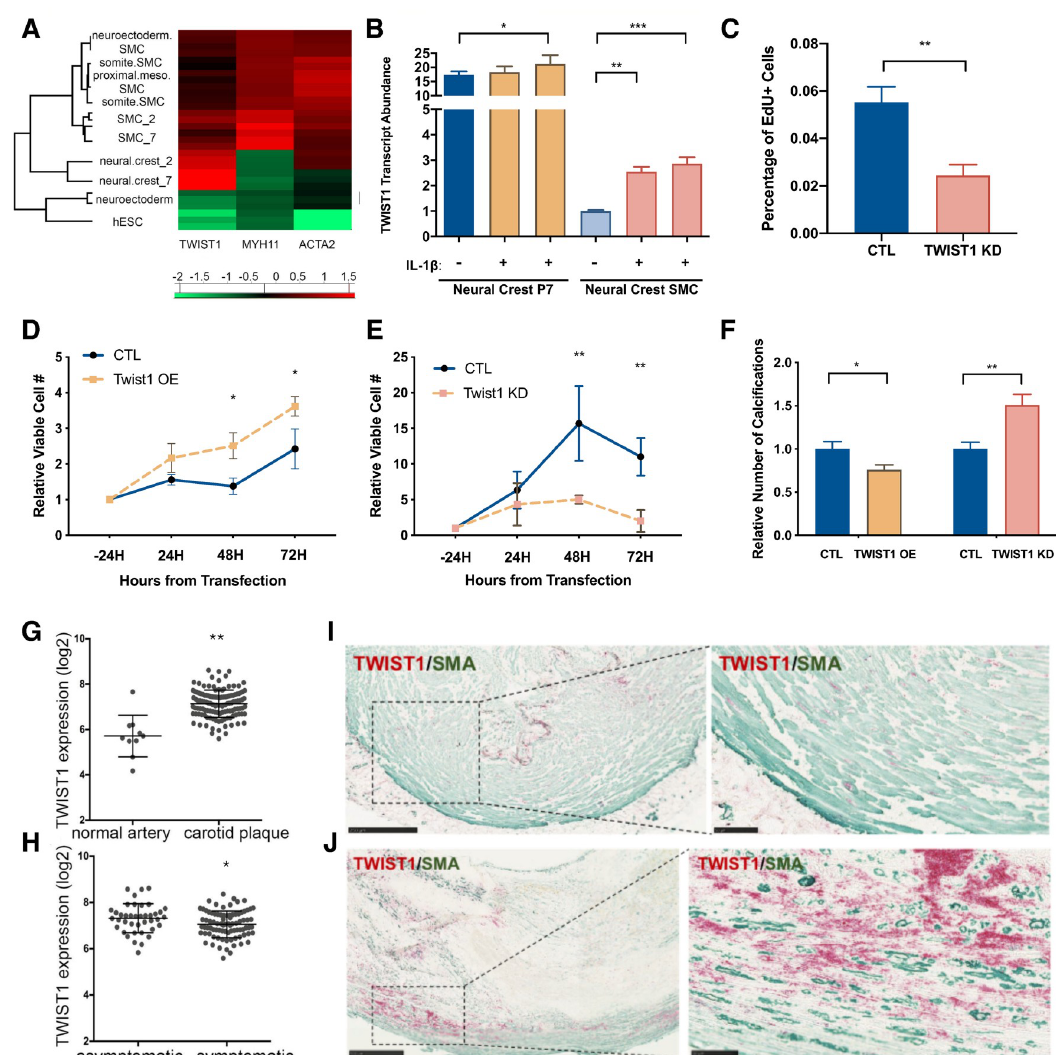
Fig 5. The role of TWIST1 in vascular cells. A) Heat map showing the differential gene expression of TWIST1 and an early stage (ACTA2) and late stage (MYH11) differentiation marker of vascular SMCs in an in vitro differentiation model. Values represent Euclidean distances from the mean across all samples at the different stages. During in vitro differentiation of SMCs, TWIST1 expression is maximal at the neural crest progenitor stage and decreases during smooth muscle cell differentiation. (hESC: human embryonic stem cells; neuroectoderm: neuroectoderm progenitors; NC_2: neural crest progenitor passage 2; NC_7: neural crest progenitor passage 7; SMC_2 NC: SMCs derived from NC_2; SMC_7: SMCs derived from NC_7; somite.SMC: SMCs derived from paraxial mesoderm progenitor; proximal.meso.SMC: SMCs derived from lateral mesoderm progenitor; neuroectoderm.SMC: SMCs derived from neuroectoderm progenitors). B) Quantitative PCR of TWIST1 expression levels in neural crest (neural crest P7) progenitor cells and neural crest derived smooth muscle cells (neural crest SMC) with and without stimulation with IL-1 β . TWIST1 expression is upregulated in neural crest-derived SMCs after treatment with IL-1 β . C) EDU assay of HCASMCs showed decreased proliferation with knockdown of TWIST1. D,E) Proliferation assay in A7r5 aortic smooth muscle cells: TWIST1 overexpression increased cell proliferation significantly at 48H and 72H after transfection, whereas TWIST1 siRNA knockdown decreased cell proliferation at 48H and 72H. F) Calcification assay in A7r5 aortic smooth muscle cells: Twist1 overexpression decreases calcification and Twist1 knockdown increased calcification based on alizarin red staining. G)–J) TWIST1 expression in human carotid tissue. TWIST1 is significantly overexpressed in diseased human carotid endarterectomy samples relative to normal arteries (E), and TWIST1 expression is higher in asymptomatic plaques relative to symptomatic plaques (F). Immunohistochemistry of normal carotid arteries show that there is low basal TWIST1 expression (red) which colocalizes with smooth-muscle-actin (SMA, green) positive SMCs in the vessel media (H). TWIST1 expression is increased in SMC-rich regions of carotid plaques (H).